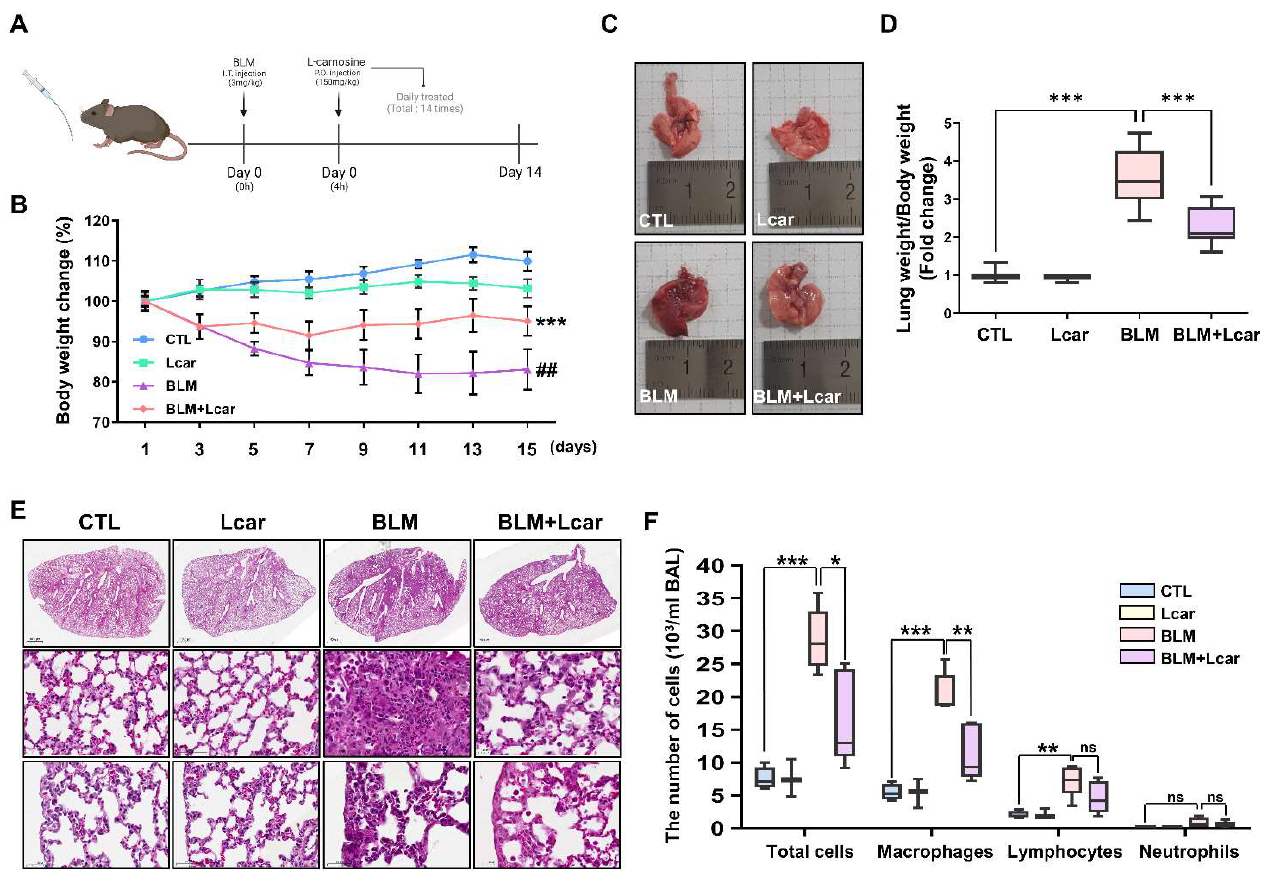
Figure 1. L-carnosine decreased pulmonary edema in bleomycin-induced fibrosis via inhibition of immune cell infiltration. For the IPF mouse model, C57BL/6 mice were injected intratracheally with bleomycin (3 mg/kg). After 4 h, L-carnosine was injected with oral administration each day. After 15 days, mice were sacrificed and lungs were harvested. ( A ) Timetable of experiment schedule. ( B ) Body weight change of each group for 15 days ( n = 5/group). *** p < 0.001 compared with the control group by one-way ANOVA. ## p < 0.01 compared with the BLM group by one-way ANOVA ( C ) Representative images of the harvested lung at each group. ( D ) Lung weight was divided by body weight ( n = 7/group). ( E ) The lung tissue was stained using H&E staining. It was pictured various regions including whole lung (top), proximal (middle), and distal (bottom). ( F ) Counting each cell type in BALF using cytospin and Giemsa staining. BAL cells were obtained from bronchoalveolar lavage fluid. ( n = 4,3,5,5/group) A value of * p < 0.05, ** p < 0.01, and *** p < 0.001 was compared with each indicated group by one-way ANOVA. I.T, Intratracheal; P.O, Per oral; CTL, Control; L-car, L-carnosine; BLM, Bleomycin; Scale bar: 1000 μm (top) or 50 μm (middle, bottom).